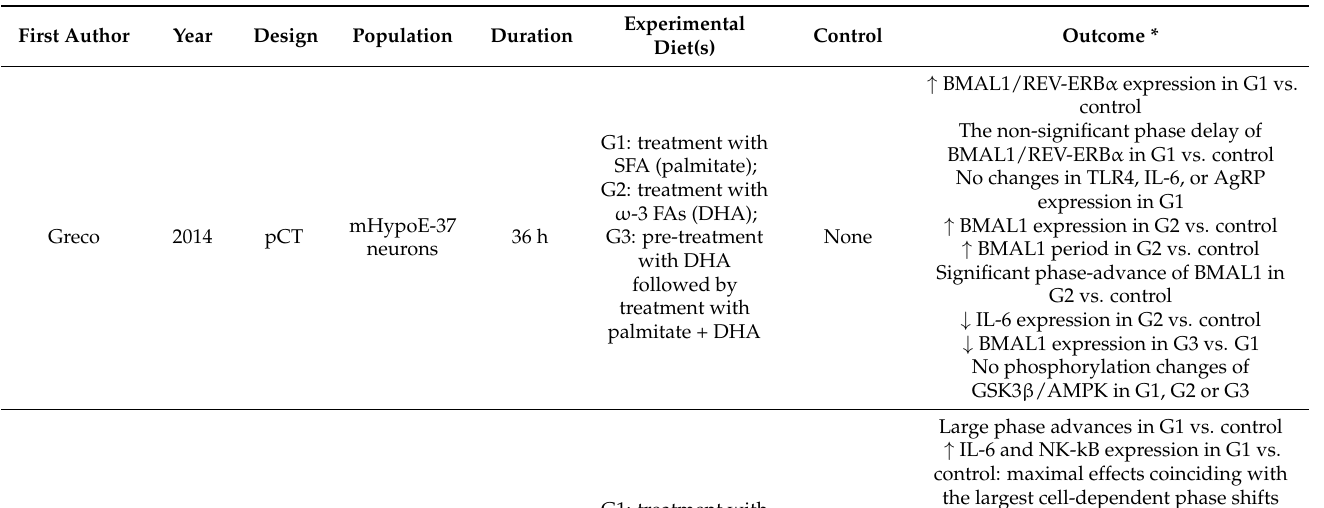
Table 2. Selected studies on the regulation of inflammatory pathways by omega-3 fatty acids via clock